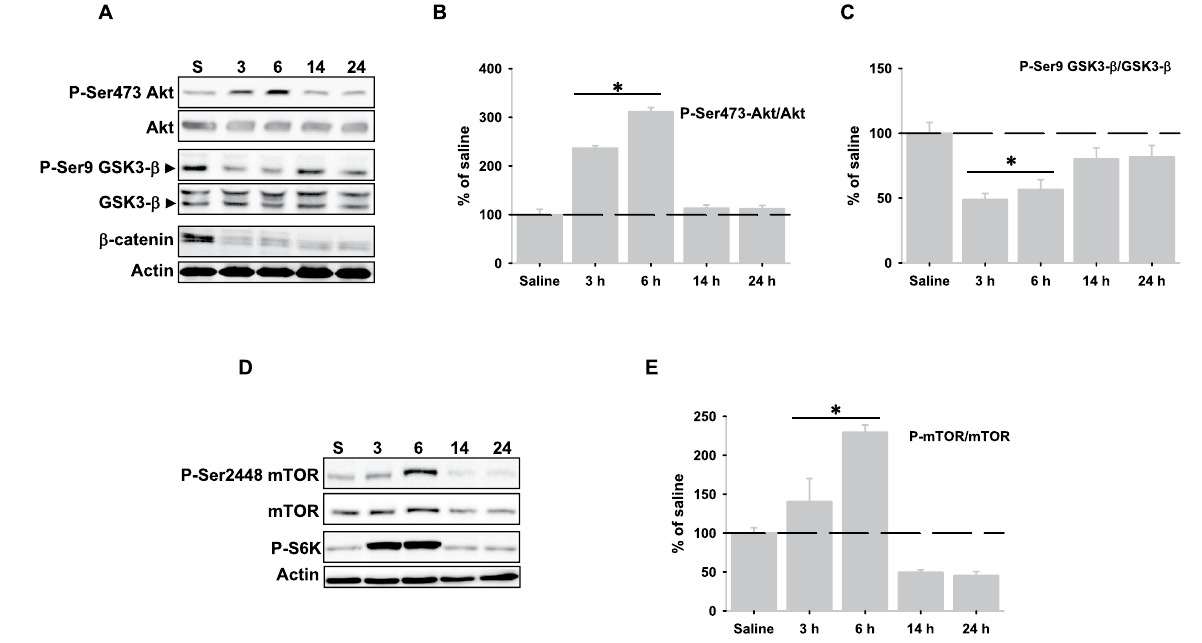
Figure 2. LPS injection activates both Akt/GSK-3 β / β -catenin and Akt/mTOR pathways in rat hippocampus. ( A ) Representative western blots of phopho-Ser473-Akt and Akt (upper panel), phospho-Ser9-GSK-3 β and GSK-3 β (middle panel) and β -catenin (lower panel). ( B , C ) Graphical representation of data from optical density quantification of western blots corresponding to phopho-Ser473-Akt/Akt and phospho-Ser9-GSK-3 β / GSK-3 β ratios, respectively after LPS injection. ( D ) Representative western blots of phopho-Ser2448-mTOR and mTOR (upper panel) and phospho-S6K (lower panel). ( E ) Graphical representation of data from optical density quantification of western blots corresponding to phopho-Ser2448-mTOR/mTOR ratio following LPS injection. Data are presented as mean ± SD (n = 4) of percentage of variation relative to controls. * p < 0.05, significant differences compared with control (saline-injected)